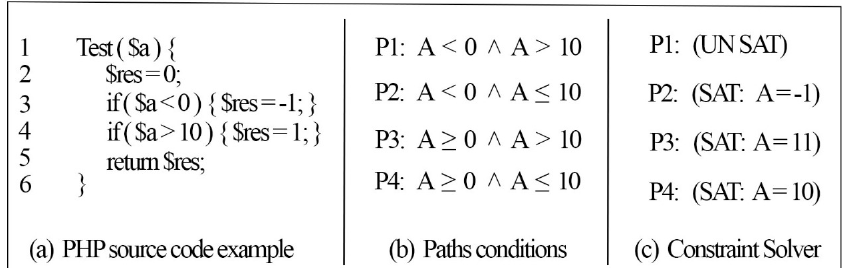
Figure 3. Path conditions example in symbolic